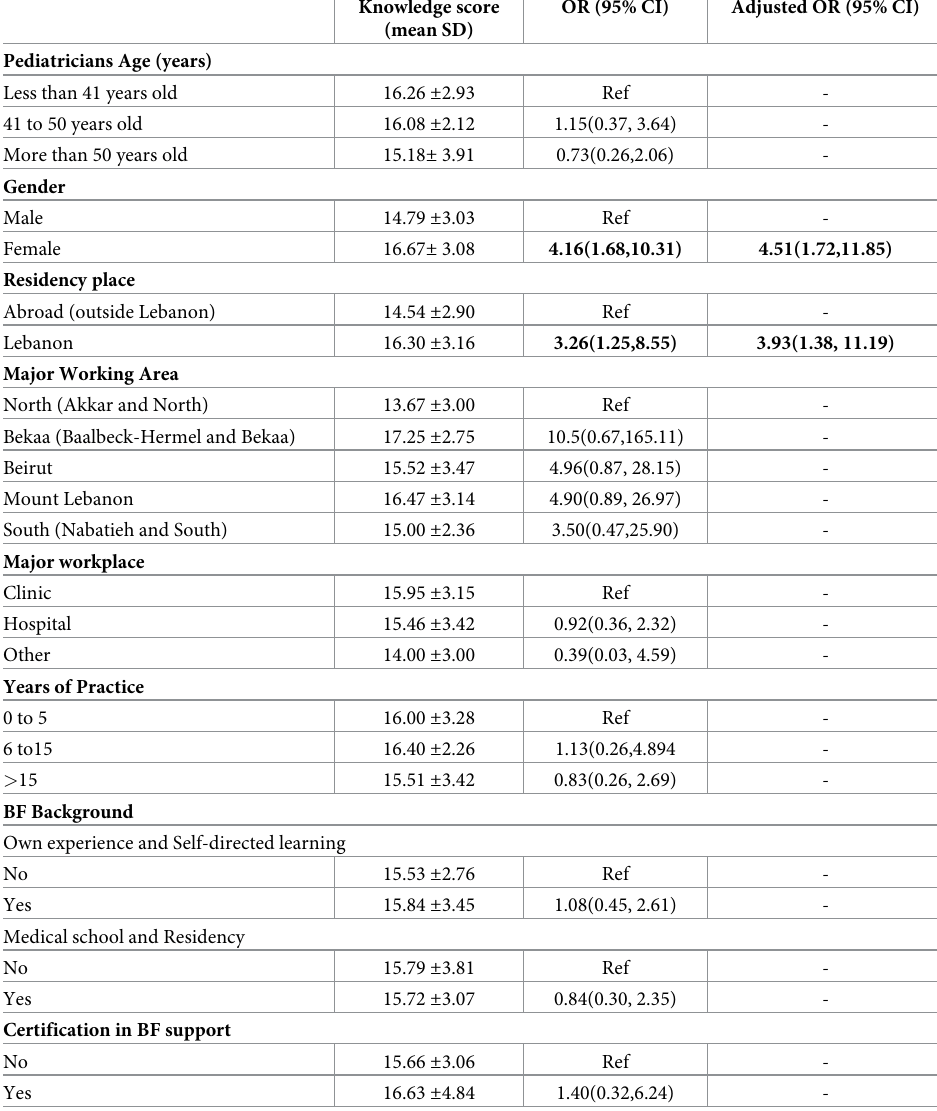
Table 5. Predictors of knowledge score related to BF support among study participants, as examined by simple and multiple logistic